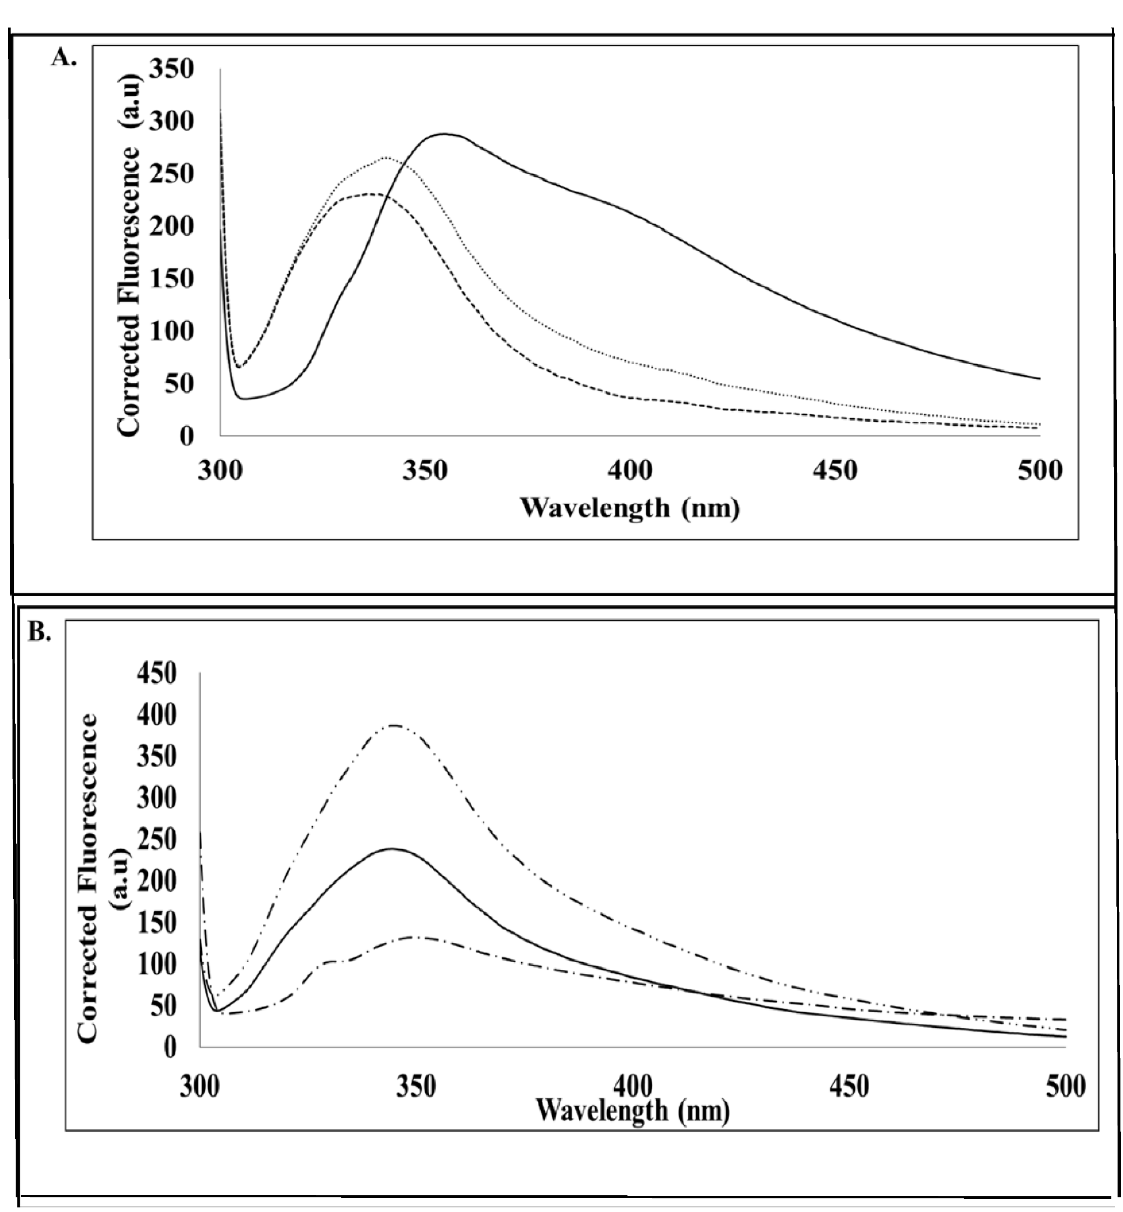
Figure 7. Intrinsic tryptophan fluorescence spectra: ( A ) spectra of 10 µM MP protein in the absence of ATP (star dashes) and bound to 10 µM MP in the presence of ATP (long dashes). The sample buffer (50 mM Tris-HCl, pH 7.5, containing 0.5 mM L -arginine) spectrum signal is represented by the solid line. Each spectrum is the average of three accumulations of three replicate samples; ( B ) spectra of 8 M urea (long and short dashes), 10 µ M MP (denatured in 8M Urea) in the absence of ATP (solid line), and in the presence of ATP (dashes and